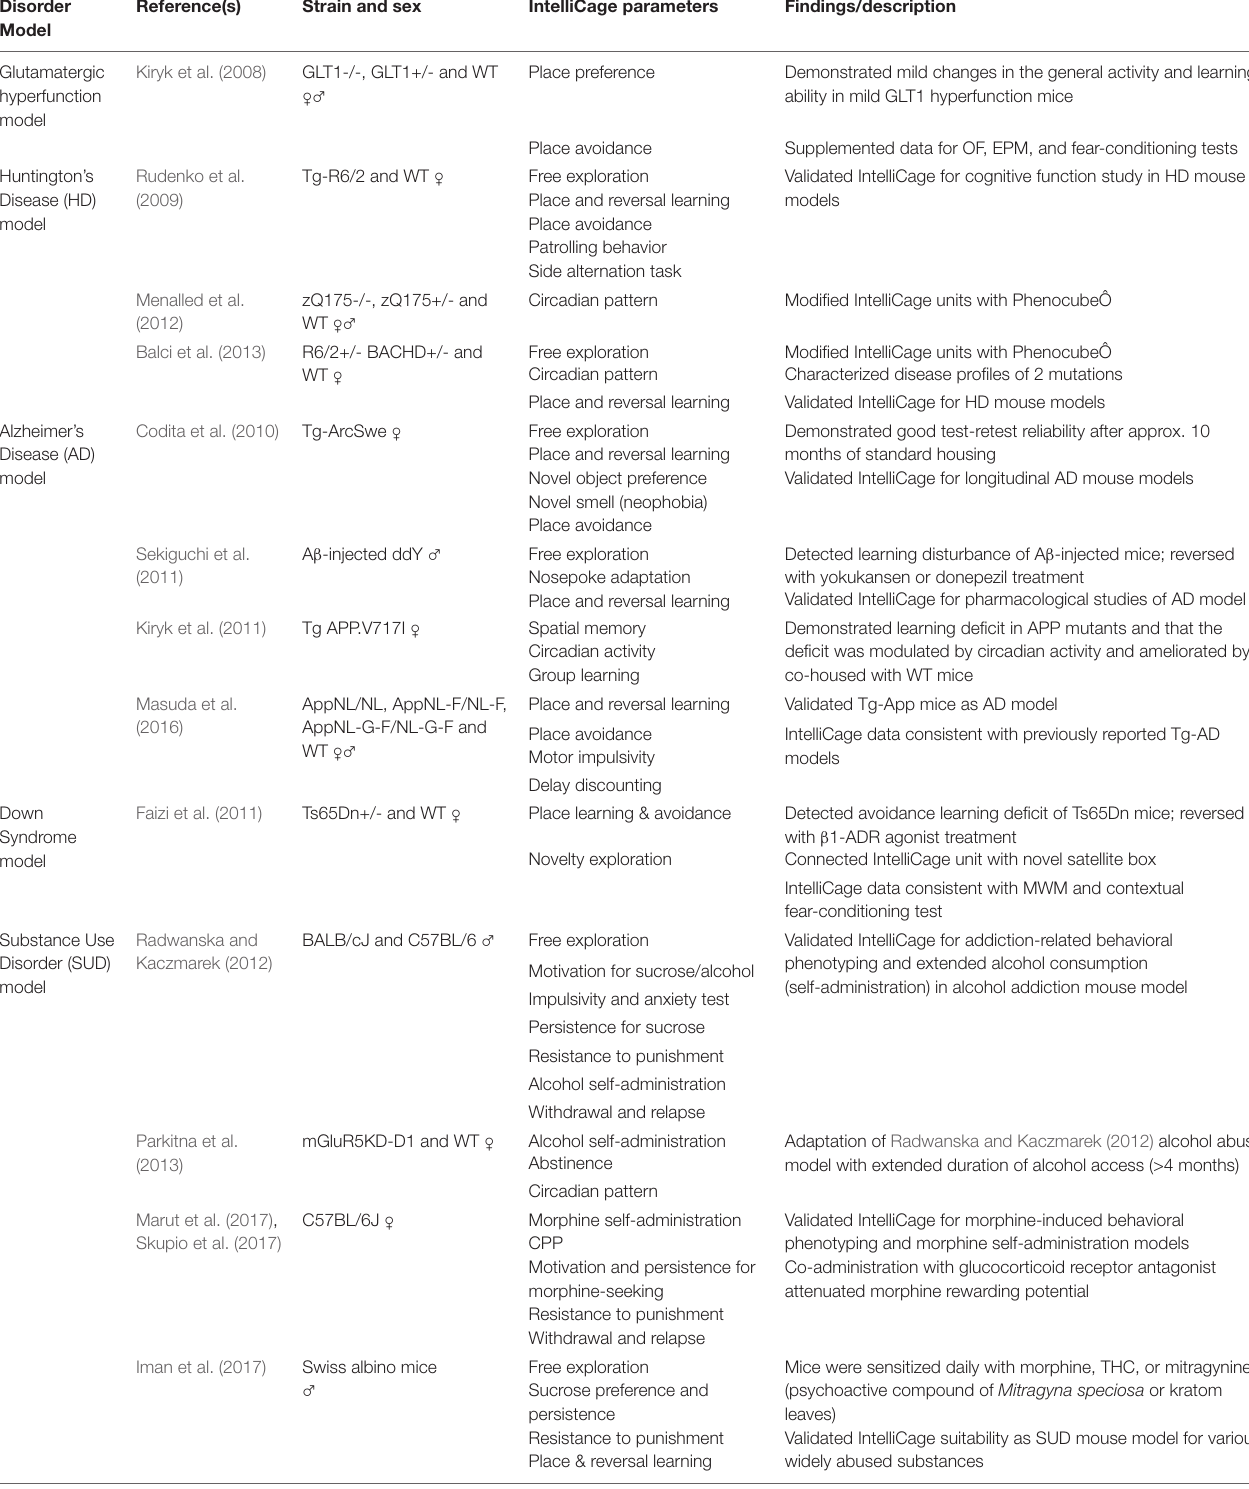
TABLE 2 | Summary of selected studies using the IntelliCage system to model human neurological